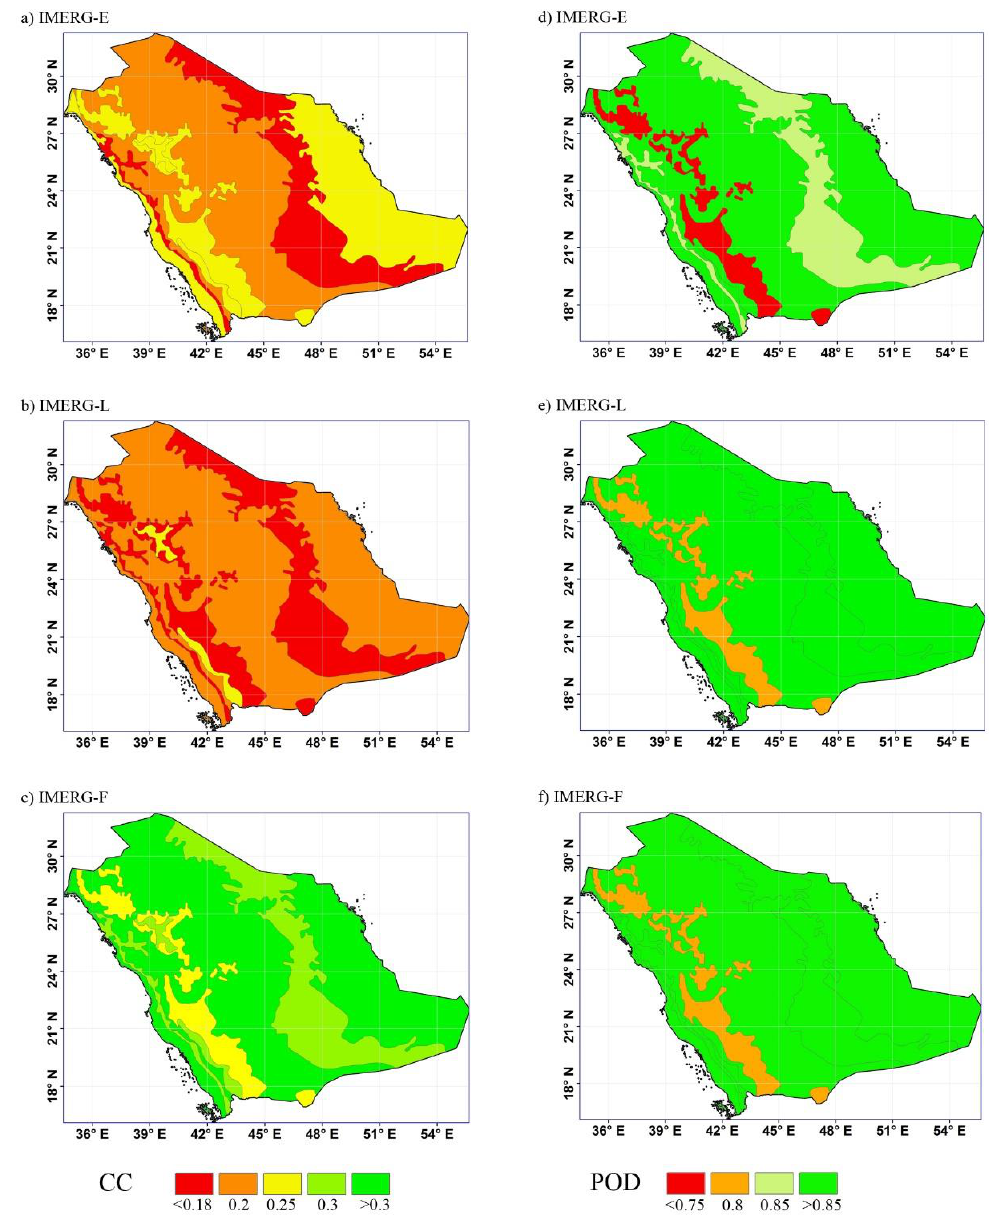
Figure 6. Evaluation of IMERG products for the different topographical regions using CC measurements for ( a ) IMERG-E, ( b ) IMERG-L, and ( c ) IMERG-F and POD indicator for ( d ) IMERG-E, ( e ) IMERG-L, and ( f ) IMERG-F.